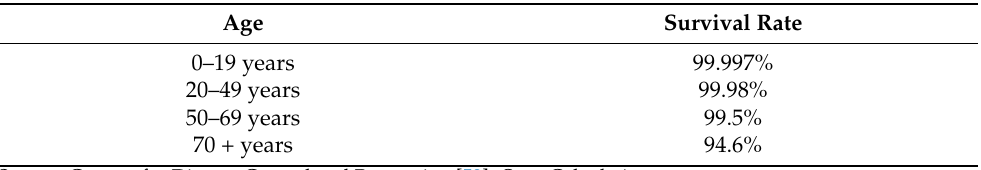
Table 1. COVID-19 survival rates per age in the US.